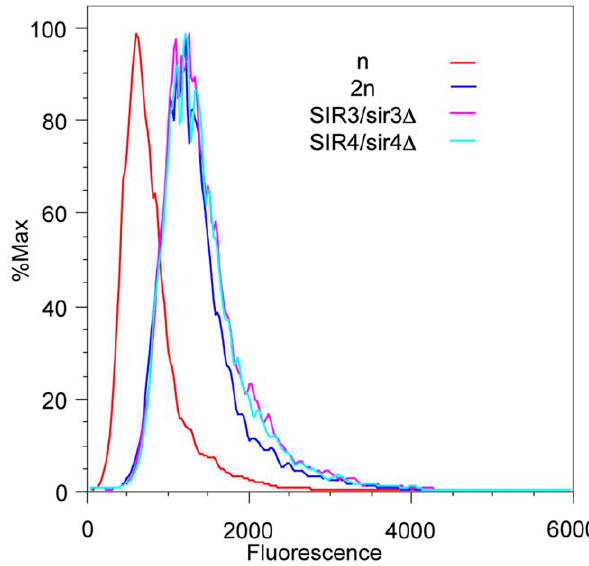
Figure 5. Neither Sir3 nor Sir4 are limiting at HML in diploid cells. A single copy of SIR3 or SIR4 was deleted from diploid cells and fluorescence levels were measured by flow cytometry. Strains on histogram plot: haploid (n, red), diploid (2n, blue), SIR3 / sir3- D (pink), SIR4 / sir4- D (turquoise).